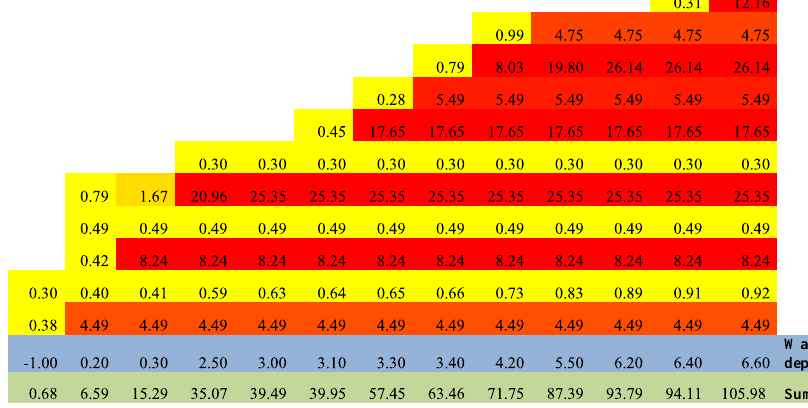
Table 4. Derivation of the building’s volume degradation for water depths related to the material in Table